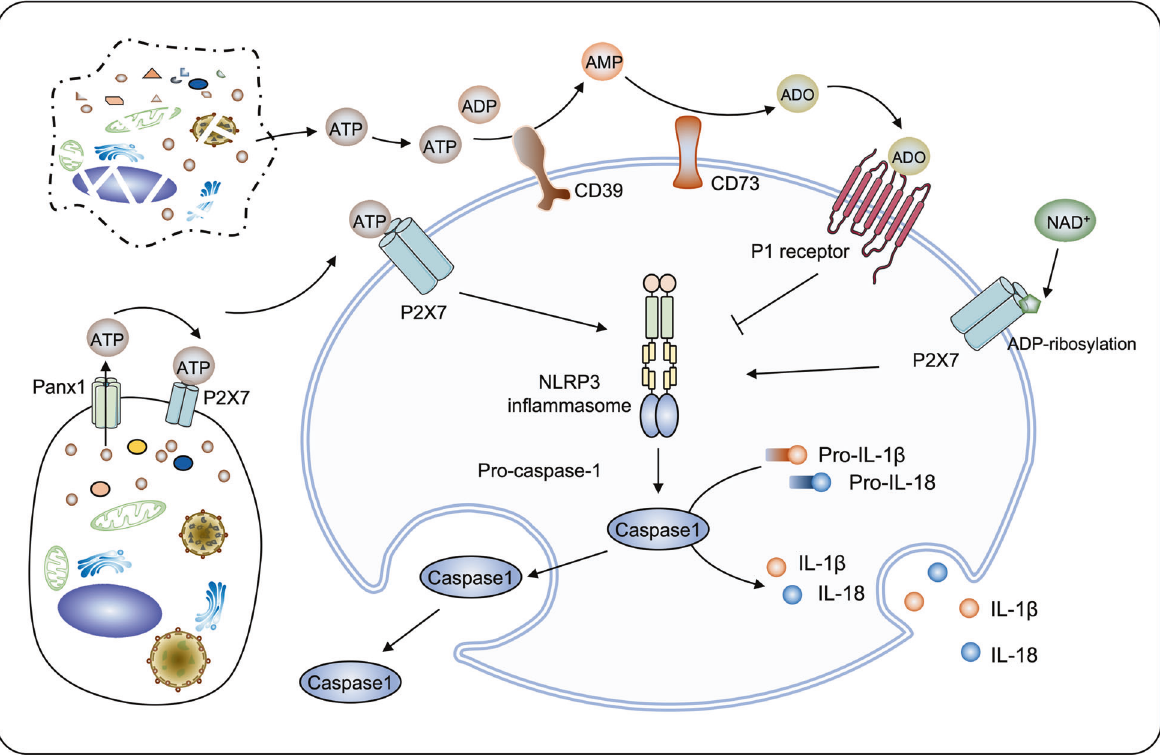
Fig. 5 Purinergic signalling regulates immune and in fl ammatory responses. Besides necrotic cells, extracellular ATP can be released from living cells through Panx1 channel. Extracellular ATP activates P2X 7 receptors, which subsequently activate NLRP3 in fl ammasome to induce the cleavage of pro-caspase-1. This effect leads to the maturation and release of caspase-1 thus initiating an immune or in fl ammatory response. Alternatively, extracellular ATP is ready to be degraded into adenosine (ADO) by ectoenzymes such as CD39 and CD73. The production of adenosine generally represses immune and in fl ammatory through binding with P1 receptors. In addition, P2X 7 can be activated by ADP-ribosylation using NAD + as an ADP-ribose